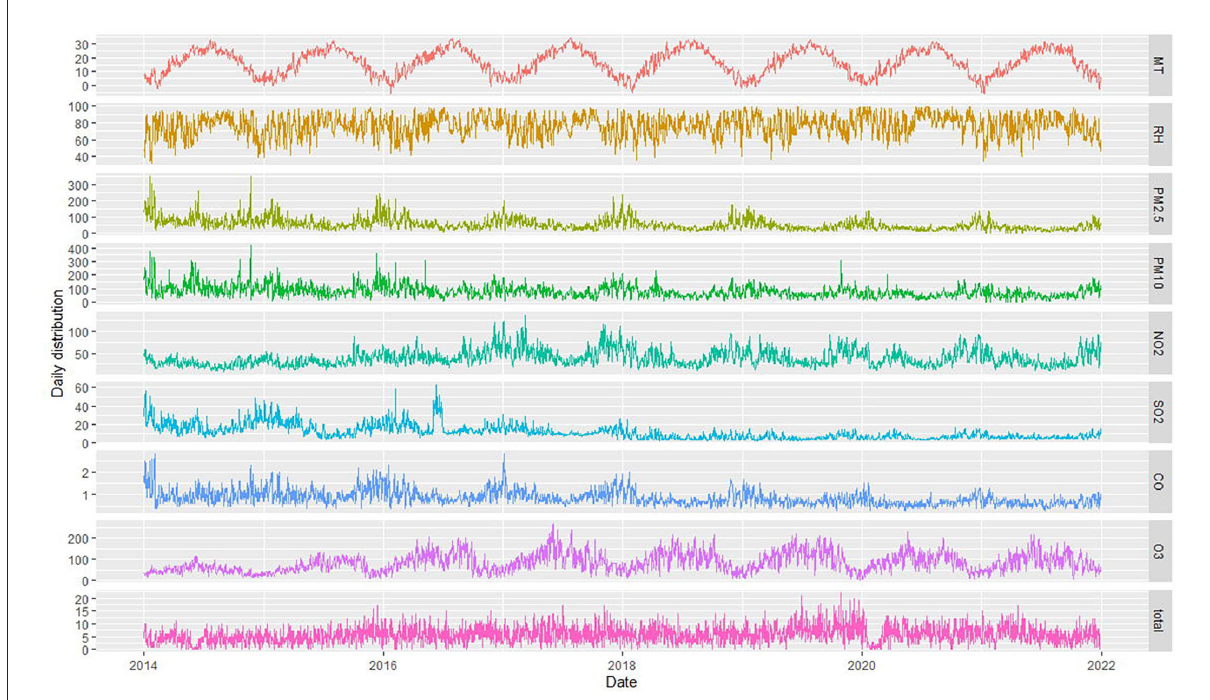
FIGURE3 Time series of air pollutants, meteorological factors, and CHD patient hospitalizations in Hefei from 2014 to 2021 (MT represents mean temperature, RH represents relative humidity, and total represents the total number of CHD hospitalization).